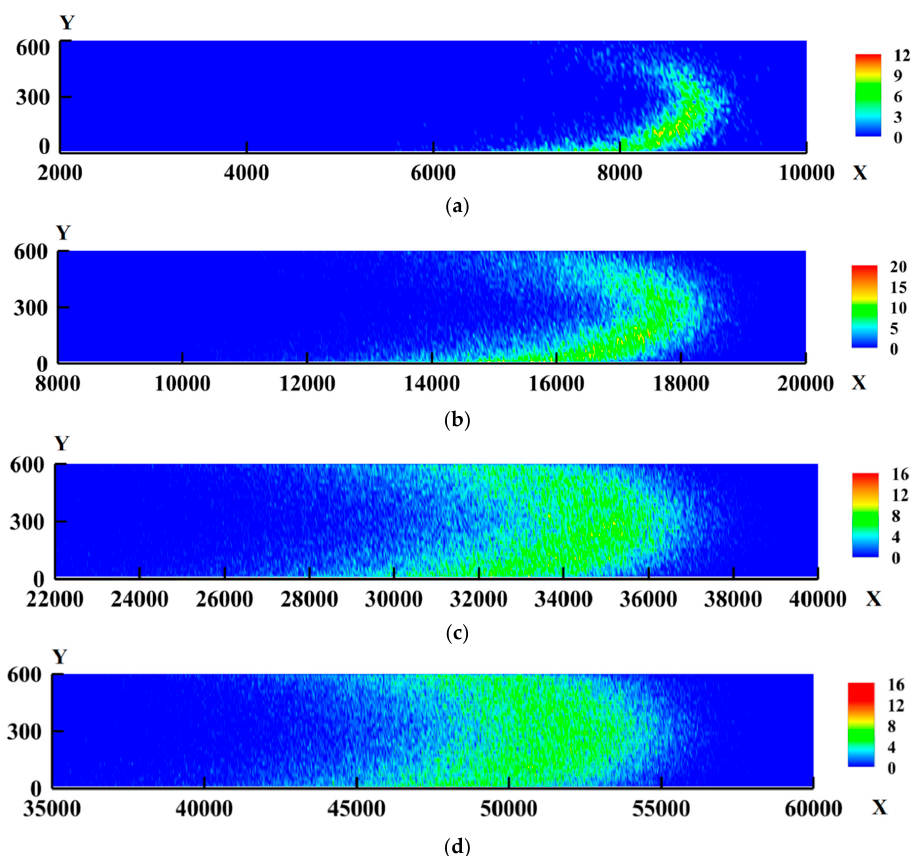
Figure 3. Development of the mixing region with time for two puffs, puff A: Sc = 0.7, y o = 300, and puff B: Sc = 0.7, y o = 15. ( a ) Contours of n AB at t = 500; ( b ) Contours of n AB at t = 1000; ( c ) Contours of n AB at t = 2000; ( d ) Contours of n AB at t = 3000.